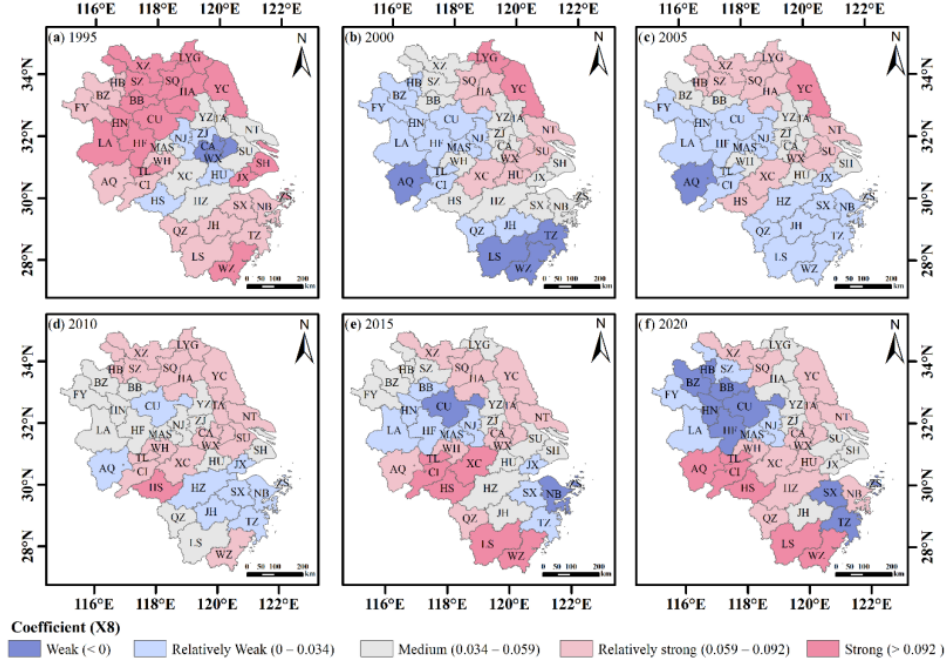
Figure A8. Spatial distribution of the regression coefficients of the social consumption.